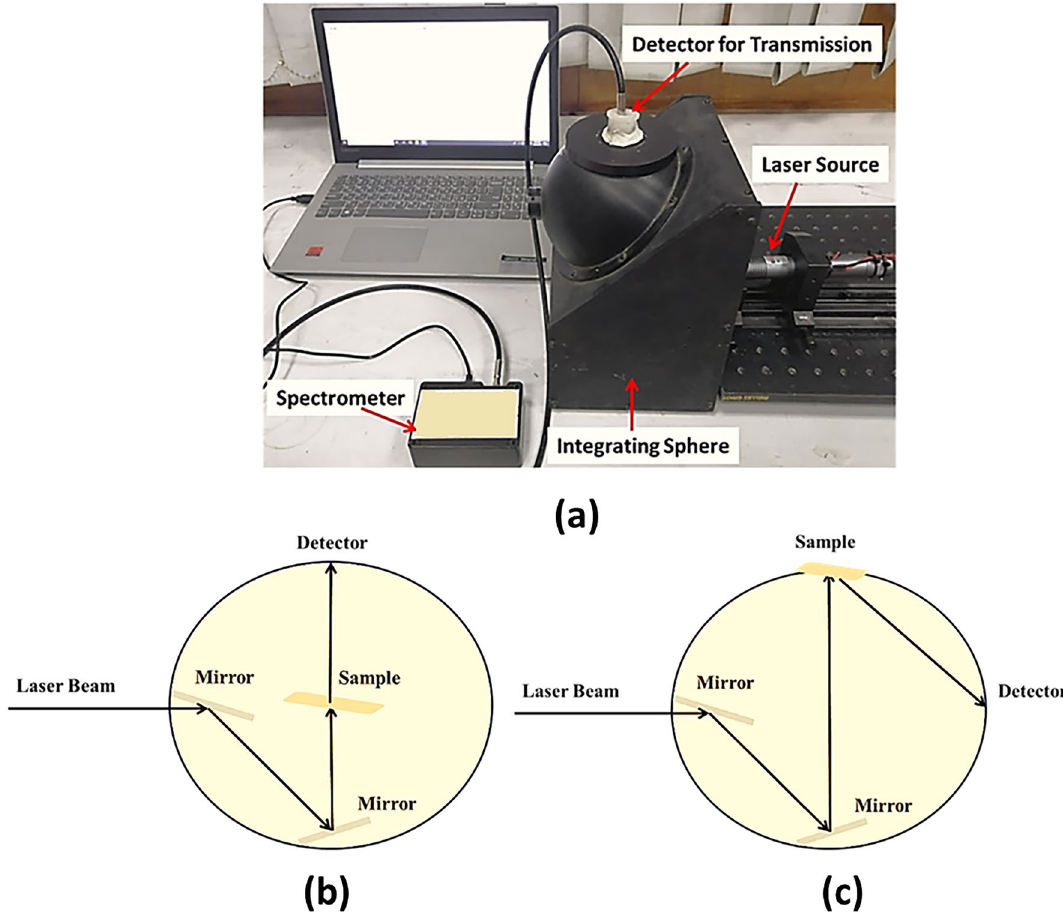
Figure 5. ( a ) The implemented optical setup using integrating sphere, ( b ) schematic of the transmission mode, and ( c ) schematic of the reflection represented by blue. The figure also illustrates the effective area at which the proposed antenna resonates at the certain frequency. Diffuse optical measurements